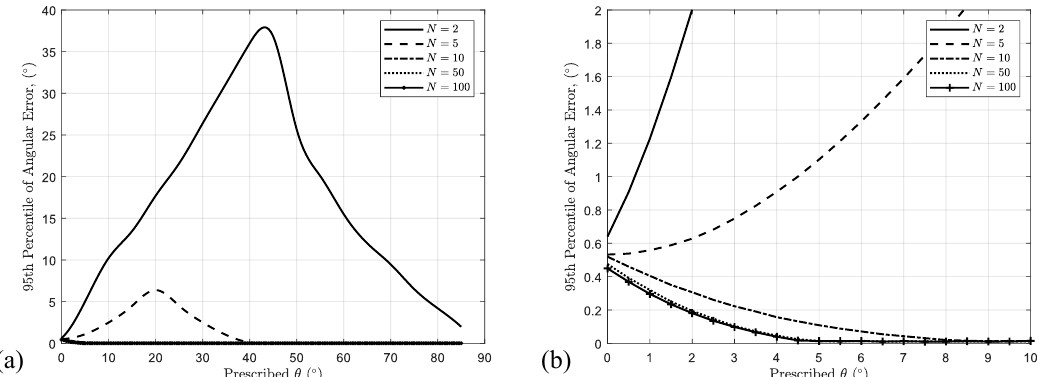
Figure 10. The 95th percentile of fiber orientation estimate angular error as a function of prescribed θ and fiber bundle size N : ( a ) full view to see error for small N ; and ( b ) limited view to see error for large N